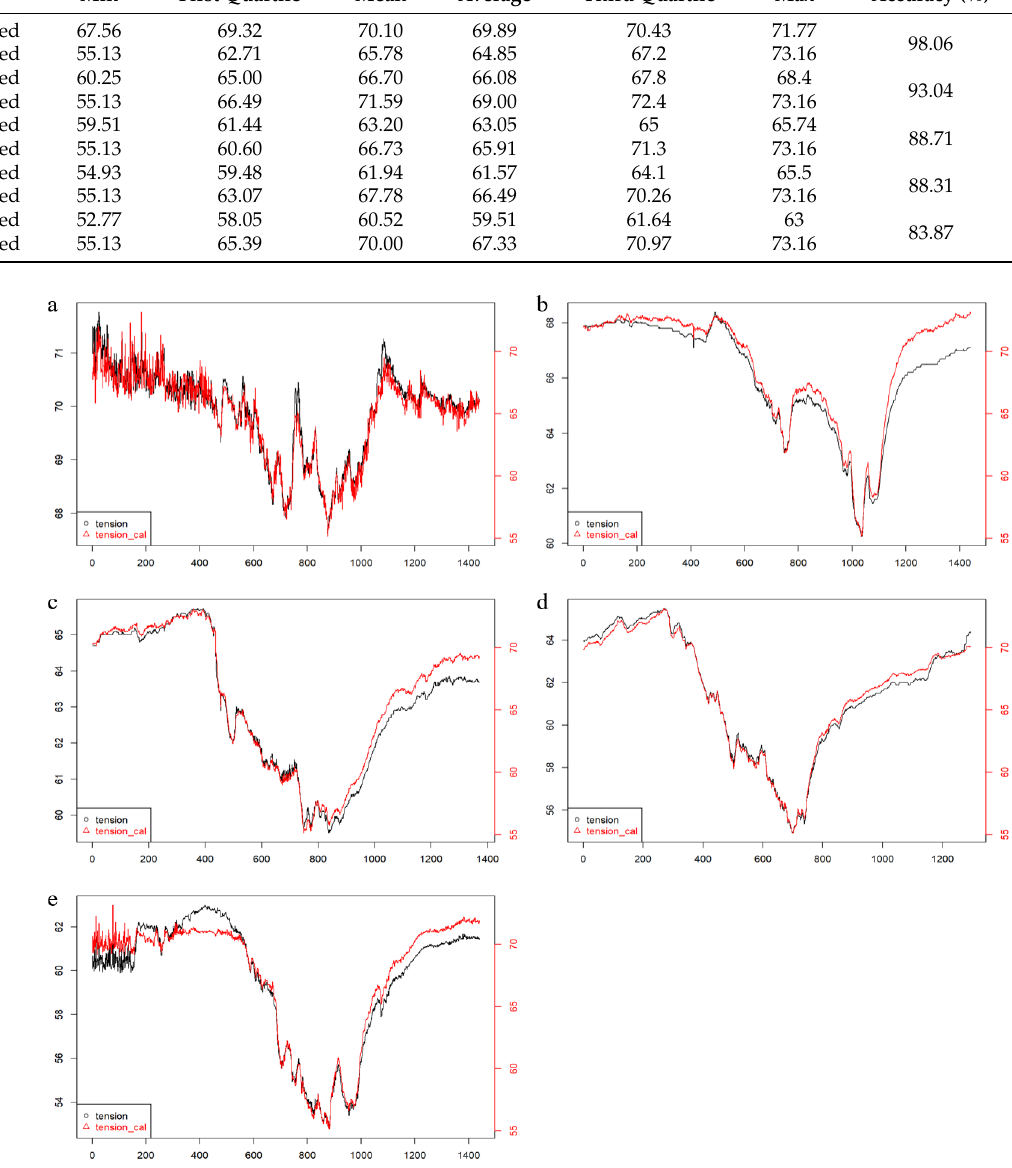
Table 4. Summary of the verifications using converted data (actual scaled).